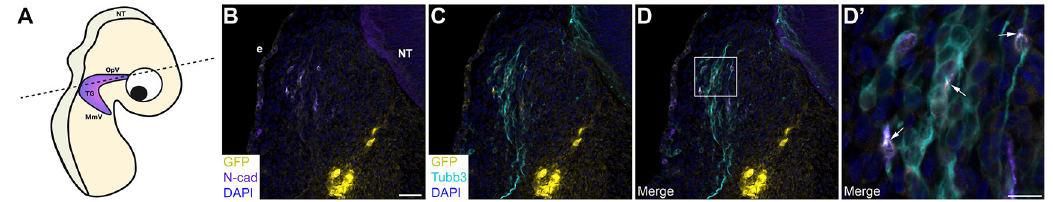
Figure 9. N-cadherin GRASP constructs expressing complementary GFP domains reconstitute GFP in cis in the trigeminal ganglion. (A) Cartoon diagram of a chick embryo showing the forming trigeminal ganglion, with the dottedlineindicating theaxiallevelatwhichimages werecaptured. Diagramcreated withBioRender.com. To target trigeminal placode cells, ectodermal electroporations were conducted in the chick embryo with both N-cad GFP1-10 and N-cad GFP11 constructs. Section immunohistochemistry for N-cad (purple; B, D, D ’ ) and Tubb3 (cyan, marks neurons placode cell-derived at this stage; C-D ’ ) was then performed. GFP signal (yellow, arrows, B-D ’ ) was captured intheappropriatechannel(488).(B-D)Representativesectionsthatshowthemorphologyofthetrigeminalganglion at this stage in development. (D ’ ) Higher magnification image of the boxed region in (D), with GFP and N-cad double- positive cells identified by arrows. Scale bar in (B) is 100 μ m and applies to (C-D), and scale bar in (D ’ ) is 50 μ m. N=3 embryos. NT, neural tube; MmV, maxillomandibular lobe; OpV, ophthalmic lobe; TG, trigeminal ganglion; e, ectoderm; N-cad, neural cadherin; GFP, green fluorescent protein; Tubb3, Tubulin beta-3 chain.